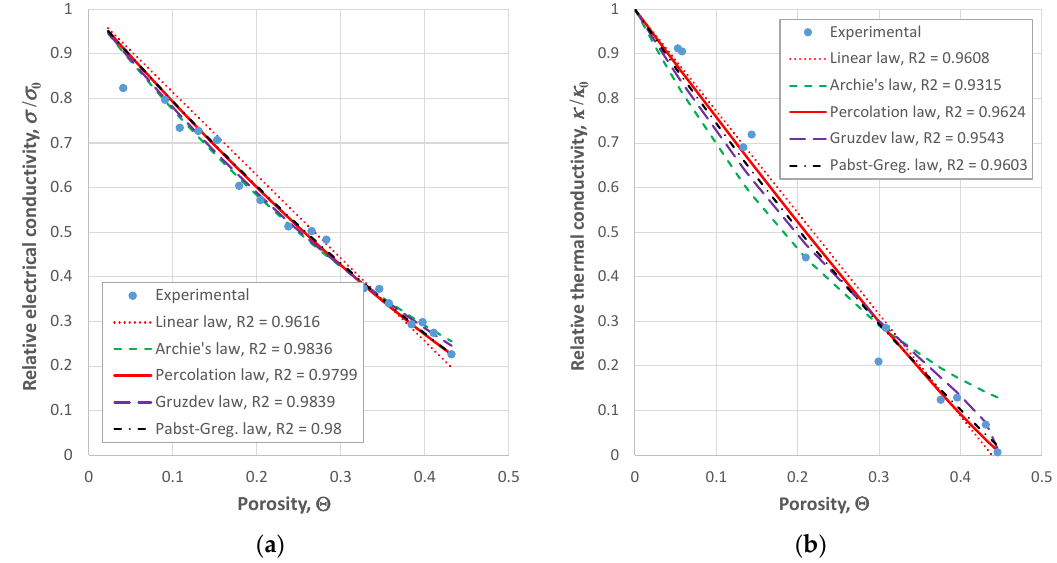
Figure 5. Experimental values of: ( a ) relative electrical conductivity vs. porosity for sintered iron powders [76]; ( b ) relative thermal conductivity vs. porosity for sintered alumina powders [79], and fitting with linear law, Archie’s law, percolation law, Gruzdev’s law and Pabst-Gregorová’s law.